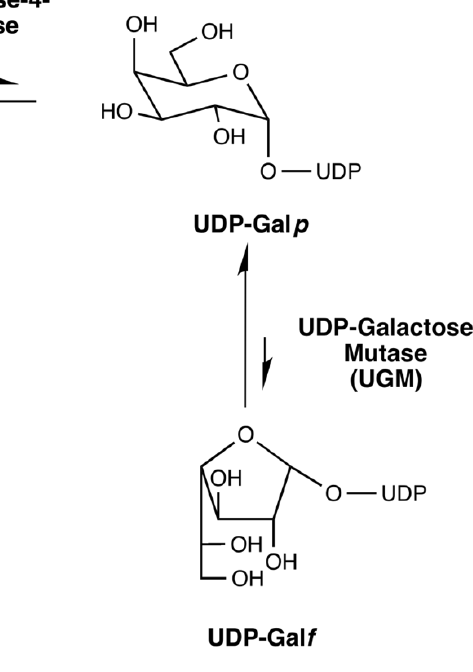
Figure 4. Biosynthesis of UDP-Gal f.